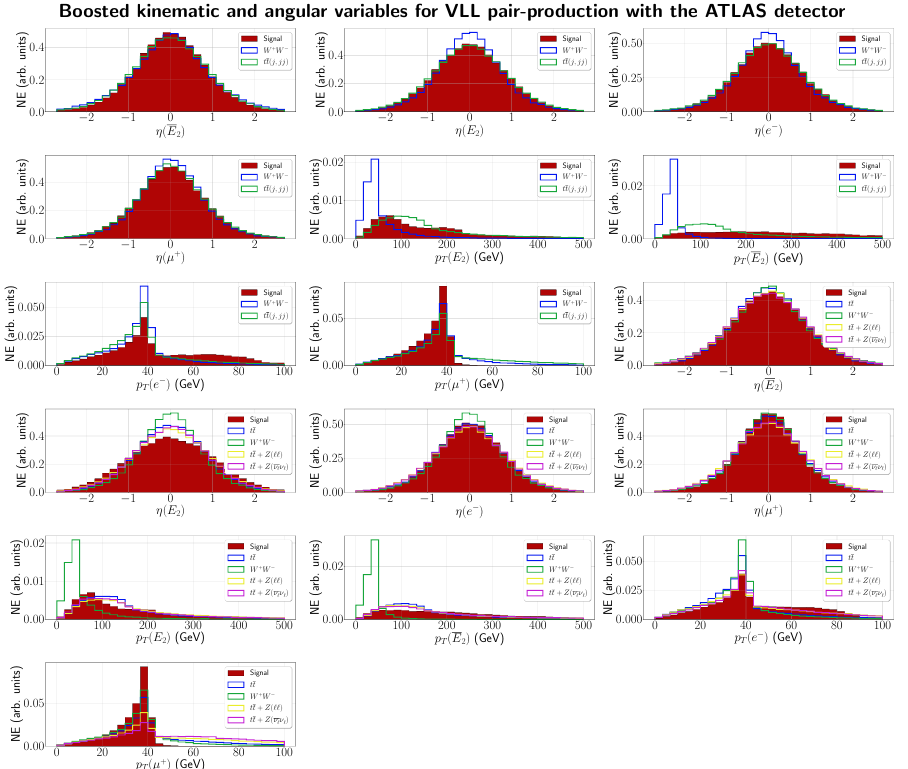
Figure 14. Set of angular and kinematic observables for VLL double-production for both VBF and ZA topologies with a mass m E = 200 GeV. All histograms are normalized, with each having 30 bins. 2 VBF channel corresponds to the plots where only two backgrounds are present, whereas ZA plots show four backgrounds. From top-left to bottom-right, for both signals, we have pseudo-rapidity distributions for ¯ E 2 , E 2 , e − and µ + and transverse momentum distributions for E 2 , ¯ E 2 , e − and µ +